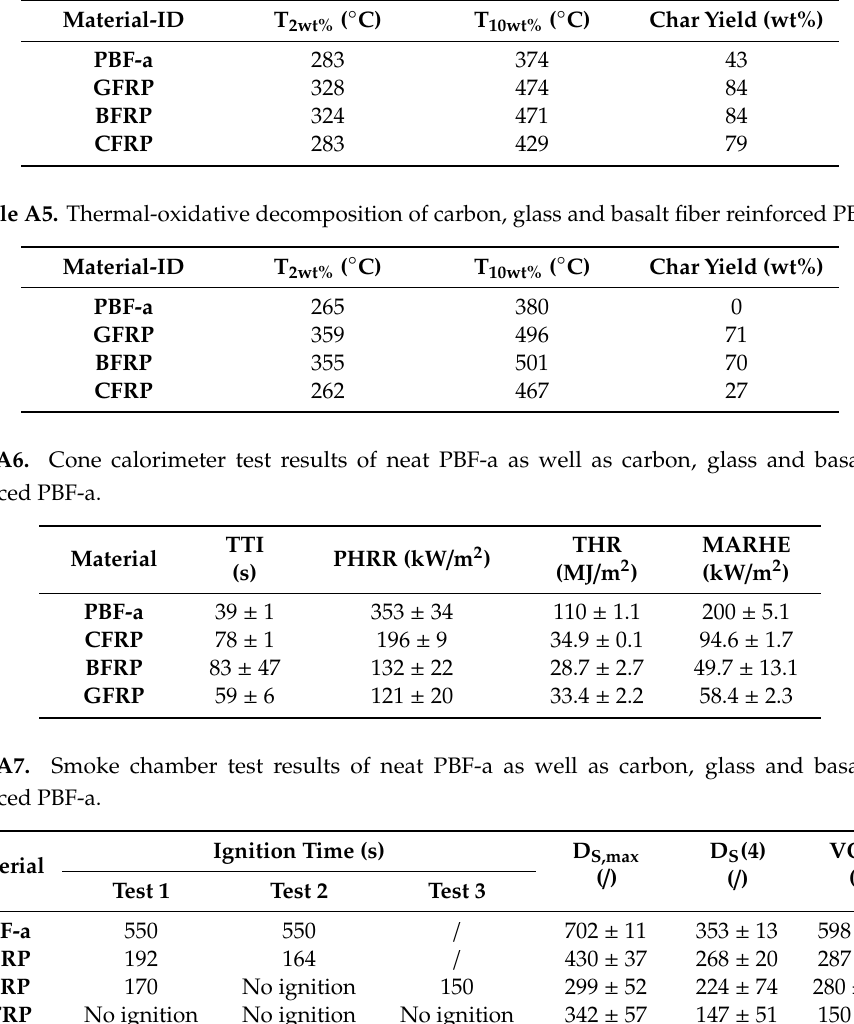
Table A4. Thermal decomposition of carbon, glass and basalt fiber reinforced PBF-a.